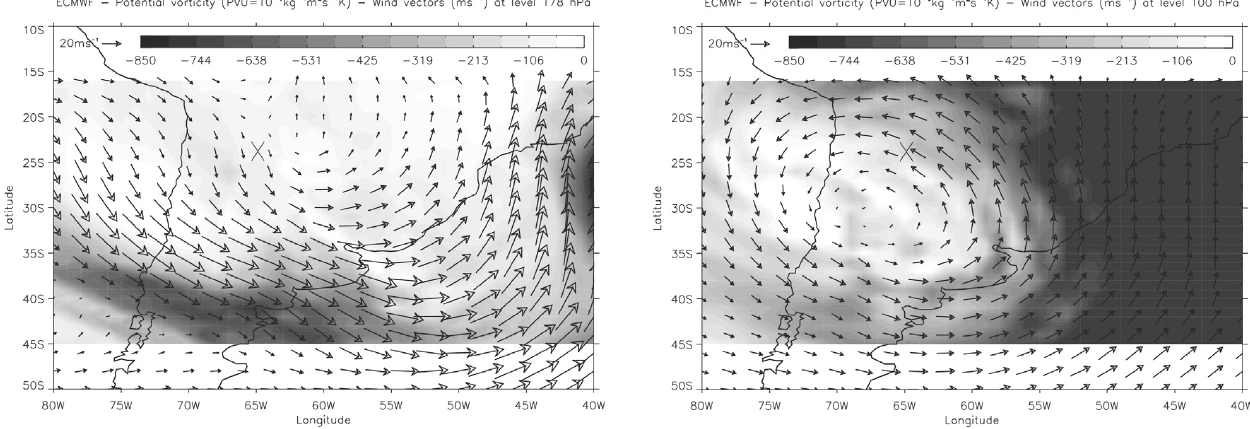
Fig. 12. Case 2: Results of the ECMWF reanalysis. Potential vorticity field (in PVU) at the 178hPa level (altitude ∼ 10.5km) (left) and at the 100hPa level (altitude ∼ 14km) (right). Values between − 850PVU and 0PVU (values respectively lower and higher than these limits are respectively black and white). Wind vectors at the corresponding levels are superimposed. Salta location is indicated by a